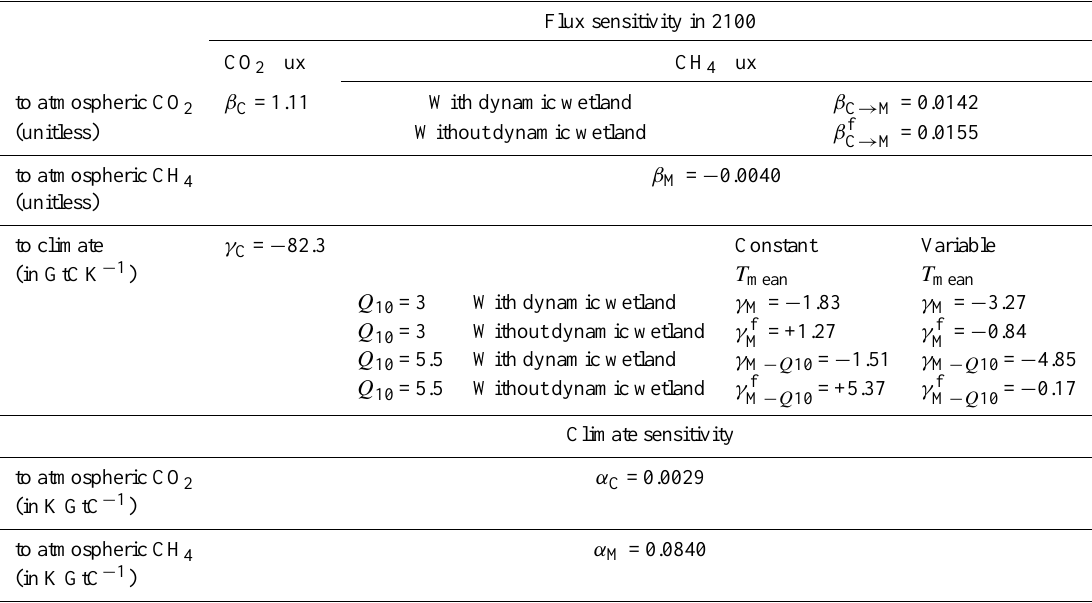
Table 2. Values of the CO 2 and CH 4 flux sensitivity in 2100 (top) as well as climate one (bottom). Given global net terrestrial CO 2 flux sensitivities are sum of ocean sensitivity terms from Friedlingstein et al. (2006) and the estimation of land flux sensitivity based on ORCHIDEE-WET simulations (cf. Fig. 4). Wetland CH 4 emissions sensitivity reported in this table are only based on ORCHIDEE-WET simulations and are also consistent to each